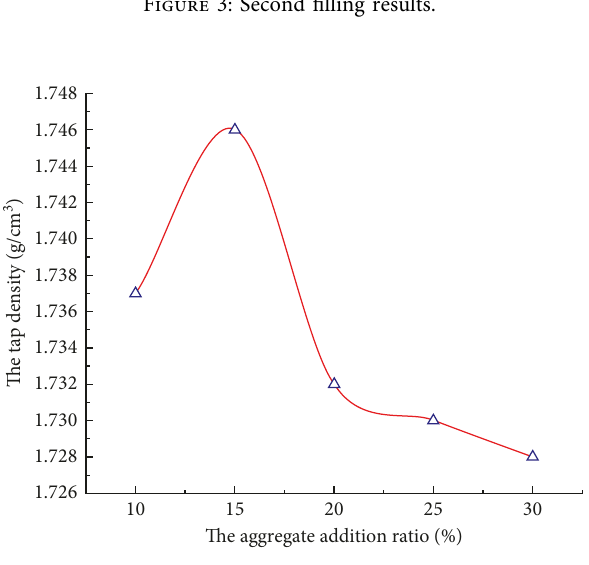
Figure 4: Third filling results.